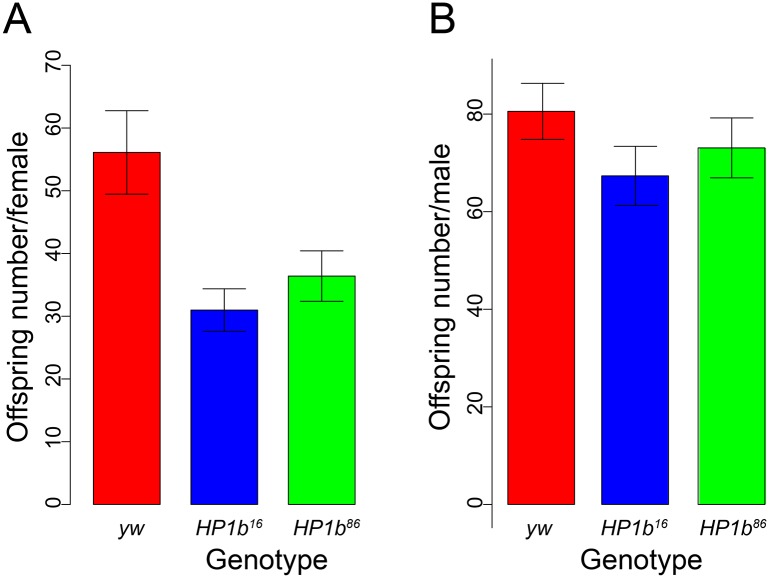
Mutations in HP1b reduce female fertility.A. The average offspring number for individual females of yw (red; n = 73), HP1b16 (blue; n = 80), and HP1b86 (green; n = 82) is shown (Y-axis). Error bars: SEM. The average number of offspring in both HP1b16 and HP1b86 females is significantly reduced compared to yw females (t test, p<0.05). B. The average offspring number for individual males of yw (red; n = 80), HP1b16 (blue; n = 73), and HP1b86 (green; n = 76) is shown (Y-axis). Error bars: SEM. The average offspring number of HP1b16 and HP1b86 males does not differ from that of yw males (t test, not significant).